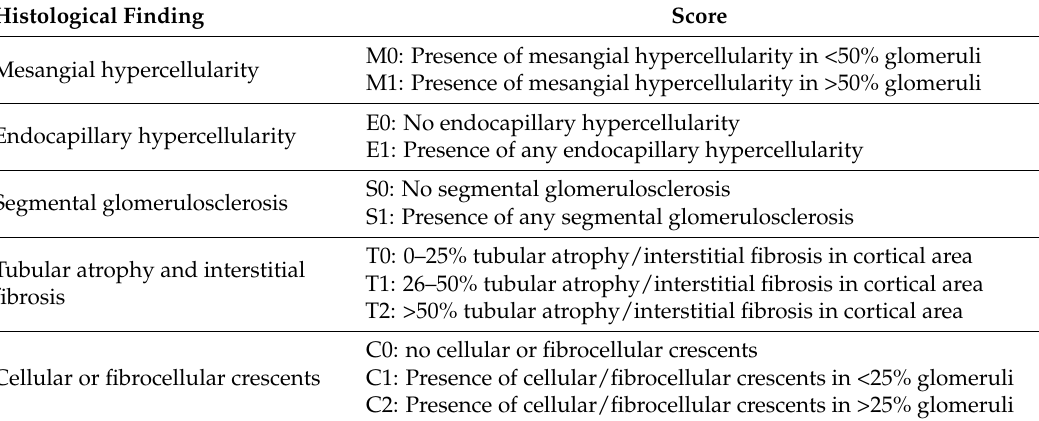
Table 1. Modified Oxford classification and MEST score system (adapted from Roberts, I. S. et al. [10]). Histological Finding